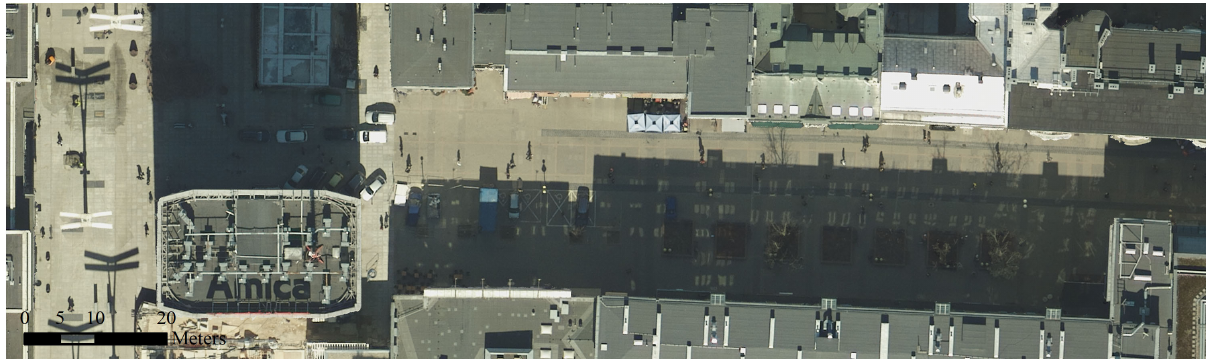
Figure 10. The example of the complex urban scene where artifacts of true orthophoto are difficult to find by manual